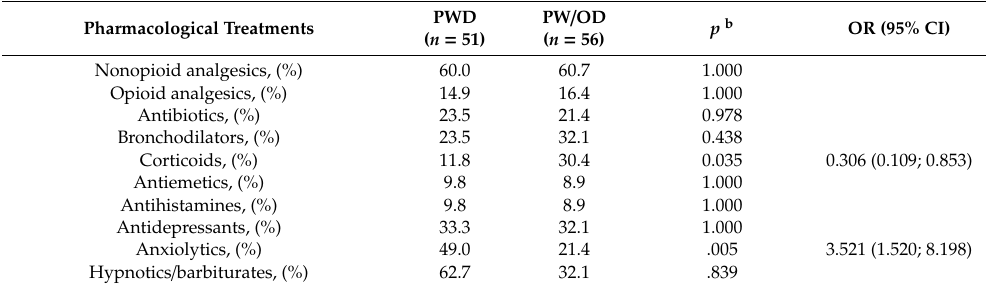
Table 4. Comparison of pharmacological treatments in patients of NH with dementia (PWD) and without dementia (PW / OD).